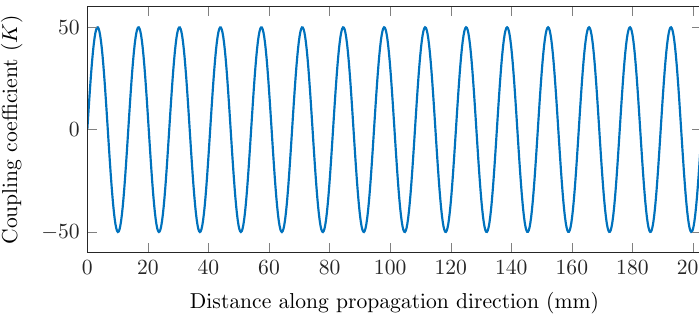
Figure 2. Variation of the coupling coefficient ( K ( z ) ) along the propagation direction ( Λ = 13.52 mm, A k = 50, n p = 15 and θ = 0).